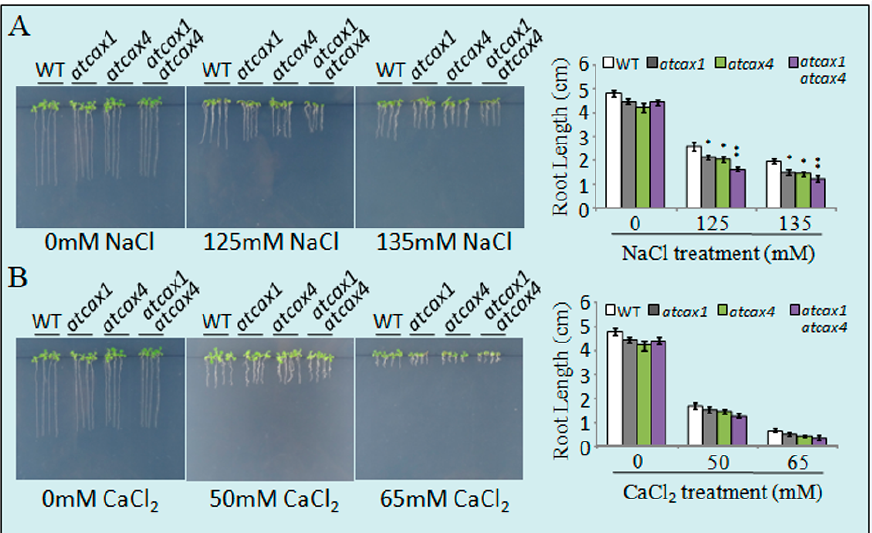
Figure 3. Stress sensitivity of wild-type (WT) and atcax1 , atcax4 , and atcax1/atcax4 plants. Seeds were germinated on half-strength Murashige and Skoog (MS) medium containing either 125 or 135 mM NaCl ( A ), 50 or 65 mM CaCl 2 ( B ). Photographs were taken 3 weeks after germination. Root length of WT and atcax1 , atcax4 , and atcax1/atcax4 plants was measured three weeks after germination. Data represent the mean ± SE of three replicates. Single and double asterisks indicate significant differences from WT at p < 0.05 and p < 0.01, respectively.